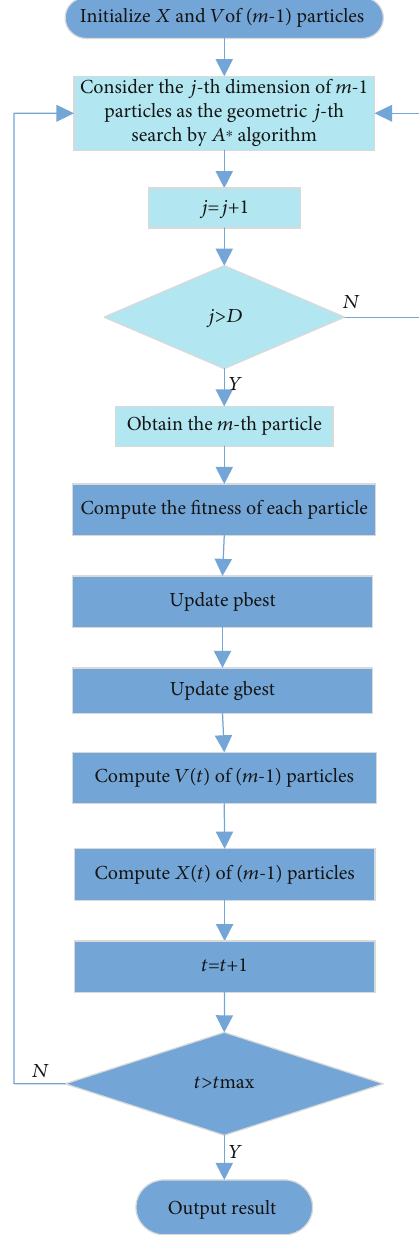
Figure 4: The fl ow chart of PSO with A ∗